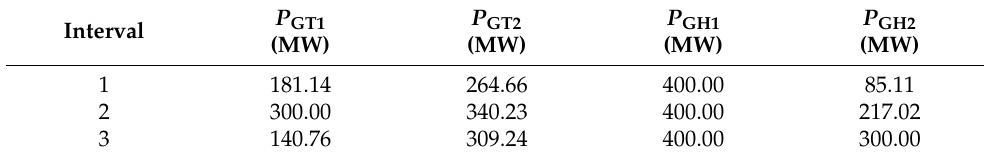
Table 1. Optimal generation scheduling of the test system [37].